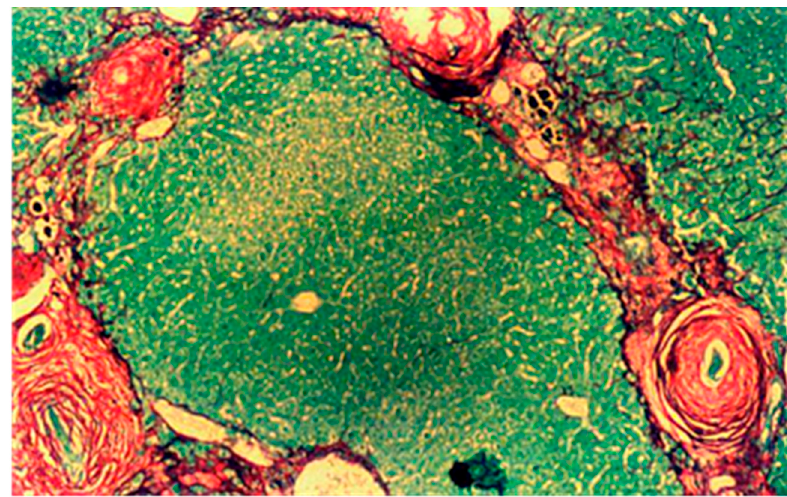
Figure 1. Liver section (×400) with S. mansoni eggs surrounded by perioval granuloma. Liver parenchyma and parasite eggs stained green surrounded by collagen I and III fibres stained red by Picro Sirius Red.